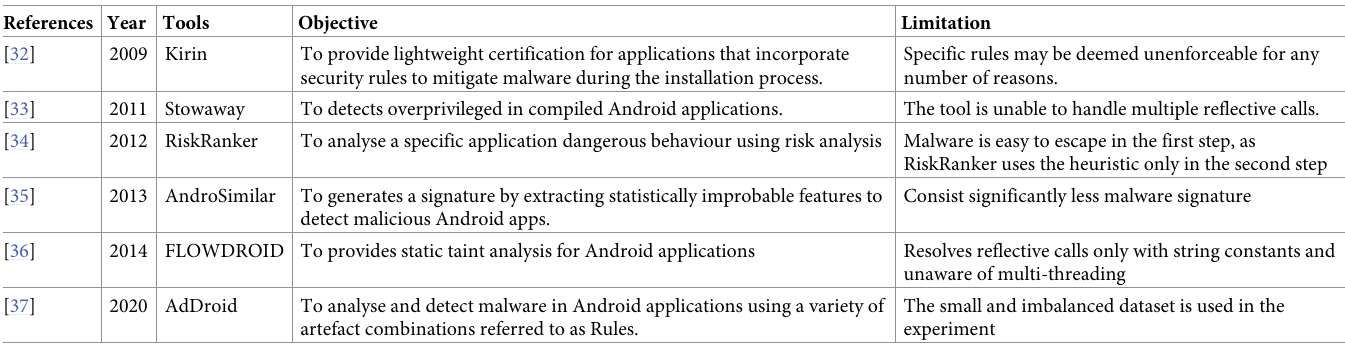
Table 1. Related work in static